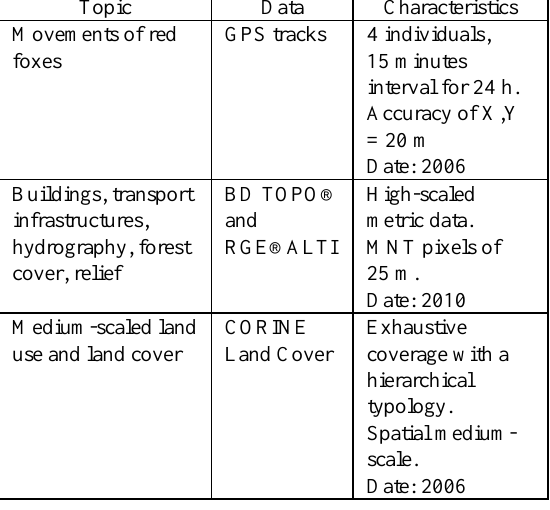
Table 1. Description of the databases